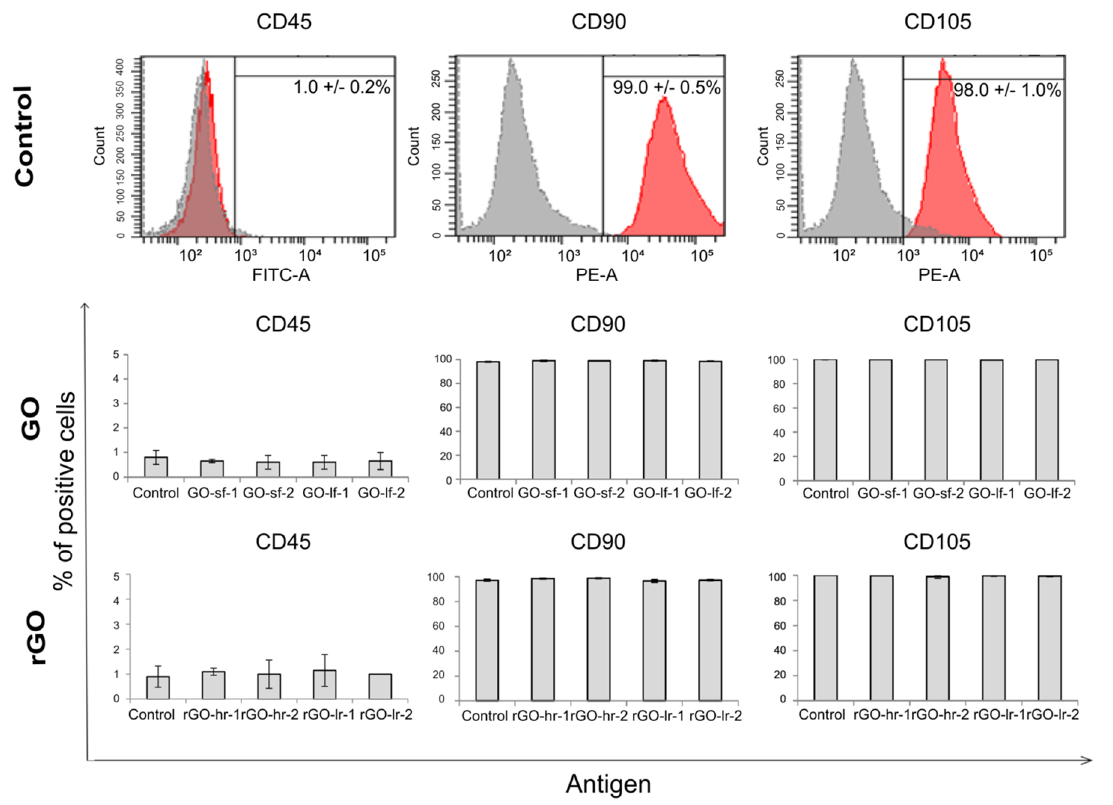
Figure 7. Phenotype characteristics of hUC-MSCs after 72 h of culture on the GO and rGO substrates. The hUC-MSCs were stained with specific monoclonal antibodies conjugated with fluorochromes (CD45-FITC, CD90-PE, CD105-PE) and analyzed using the LSR Fortessa flow cytometer. The representative histograms (for TCPS, panel A), as well as the charts indicating the expression level of the selected antigen (for the GO and rGO surfaces, panel B), are presented. Legend: GO-sf-1: small flakes/thick layer; GO-sf-2: small flakes/thin layer; GO-lf-1: large flakes/thick layer; GO-lf-2: large flakes/thin layer; rGO-hr-1: high reduction level/thin layer; rGO-hr-2: high reduction level/thick layer; rGO-lr-1: low reduction level/thin layer; rGO-lr-2: low reduction level/thick layer; Control: tissue culture plastic surface (TCPS).